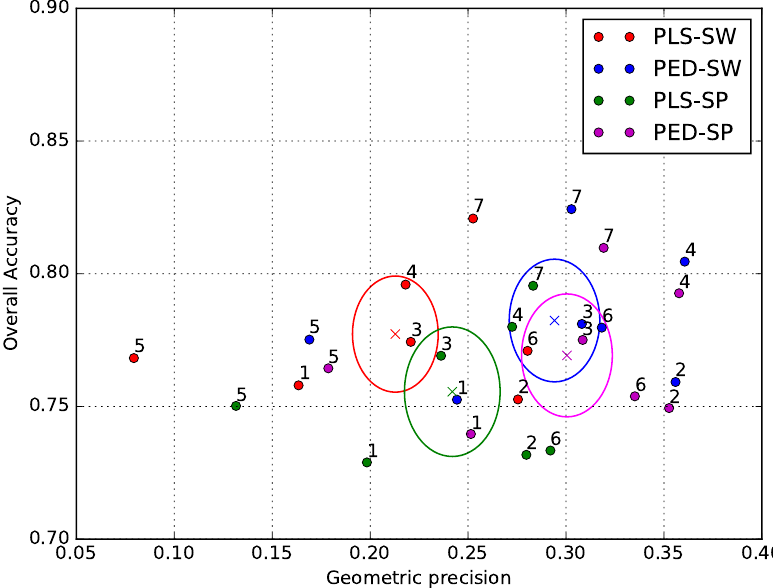
Figure 16. Overall Accuracy plotted against geometric precision for the tiles numbered 1–7 in the experimental data set (see Table 3 for the equivalent tile names). P indicates the presence of pixel information, LS stands for local statistics, and ED for edge density. The centers of the ellipses, symbolized by crosses, are placed on the coordinates of the average score over the 7 tiles. The size of the ellipses represents the standard